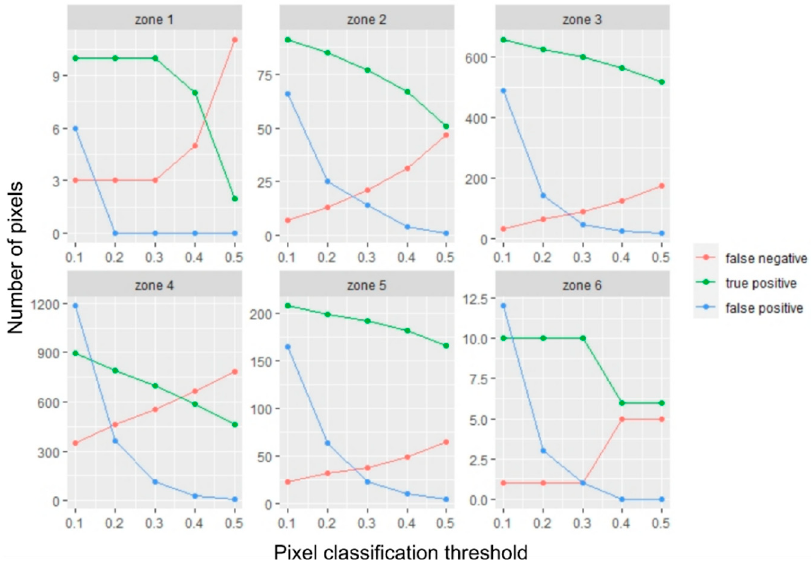
Figure 5. Impacts of the random forest prediction threshold on the sensitivity and specificity re ‐ sults.